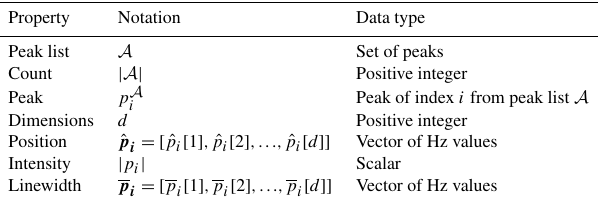
Table A1. Metric notation. These symbols are used to define the quantitative functions for the evaluation